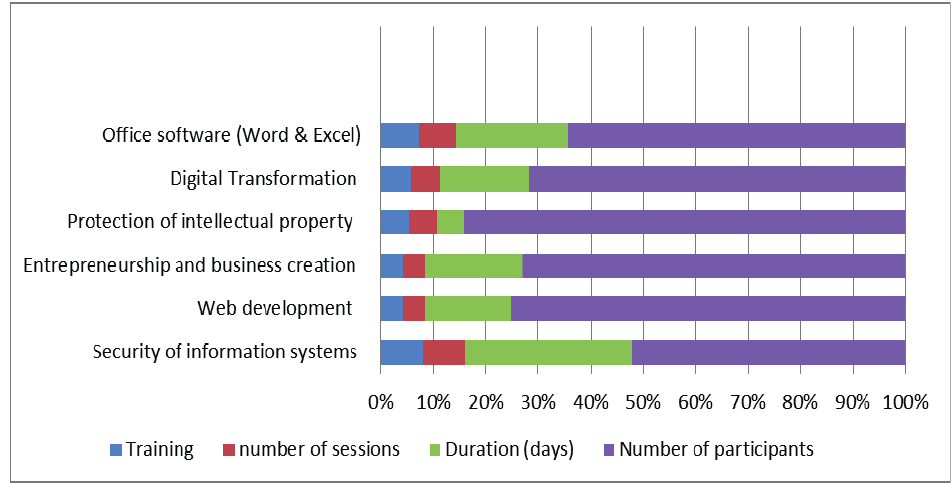
Fig. 6. Training courses held during the 1 st quarter of 2020 (the author’s contributions based on the documentation provided by NATP,